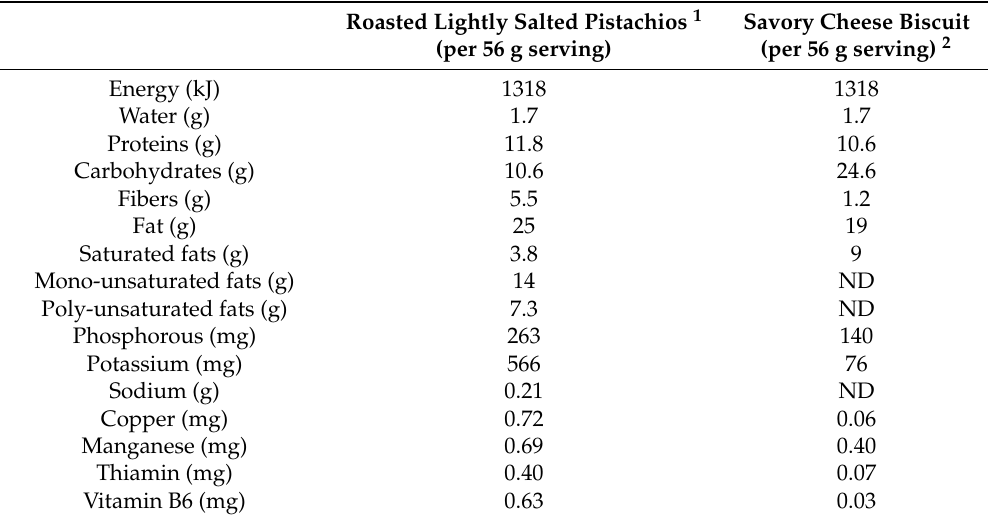
Table 1. Nutrient content of